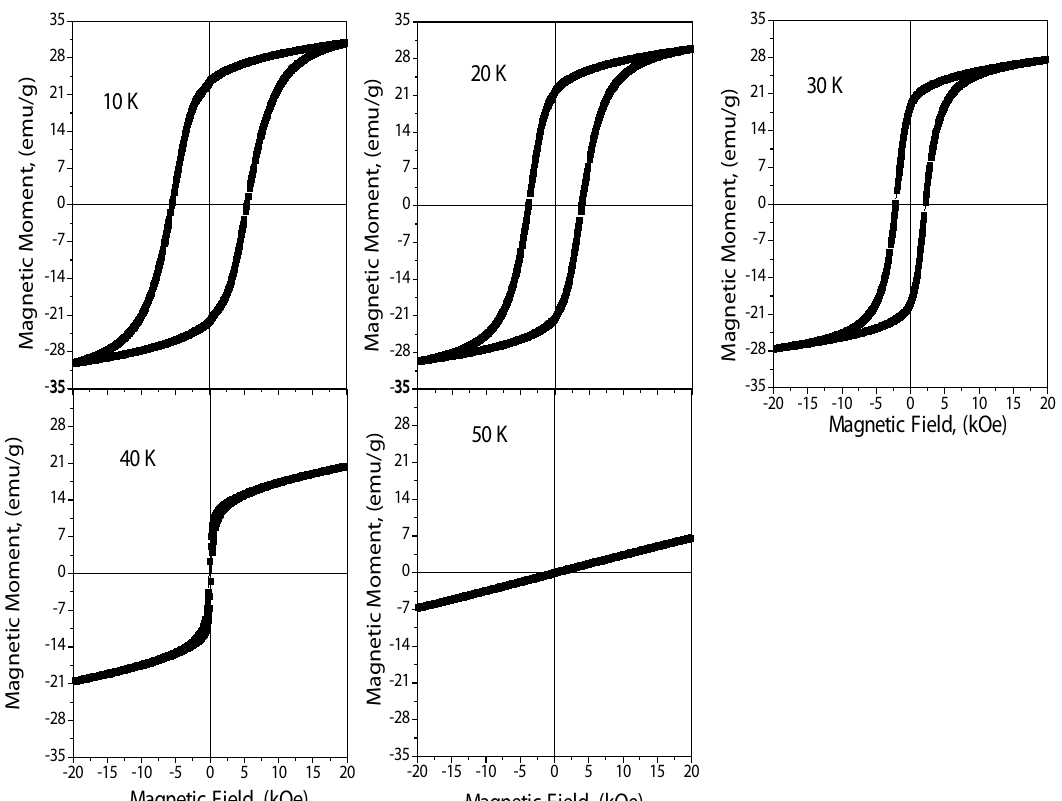
Figure 5. Magnetization (M) as a function of external magnetic field (H) at different temperatures for sonochemically synthesized Mn